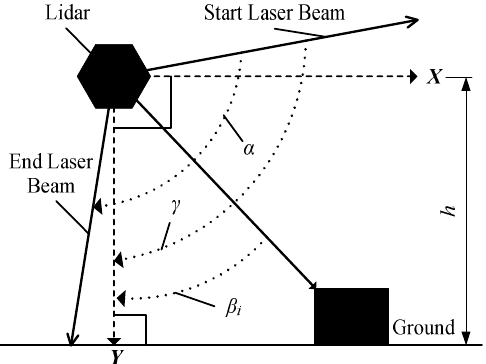
Figure 5. Calibration related angles.